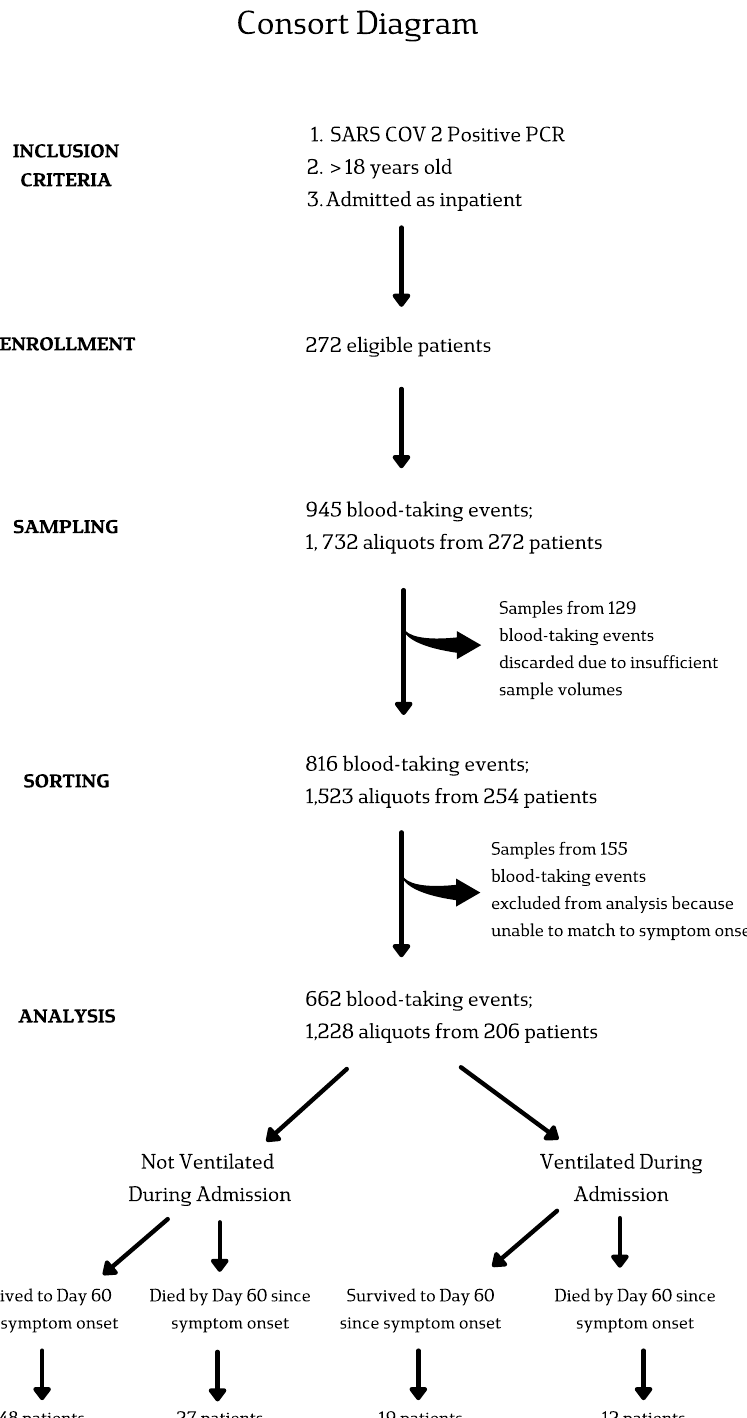
Fig. 1 Consort diagram. Inclusion criteria enabled enrolment of 272 eligible patients, from whom 1732 aliquots of serum and Ethylenediamine tetraacetic acid (EDTA) plasma and serum blood samples were obtained. Discarding of samples due to insufficient volumes for enzyme-linked immunosorbent assay (ELISA) left 1523 aliquots, of which, 1228 could be matched to day from symptom onset, from 206